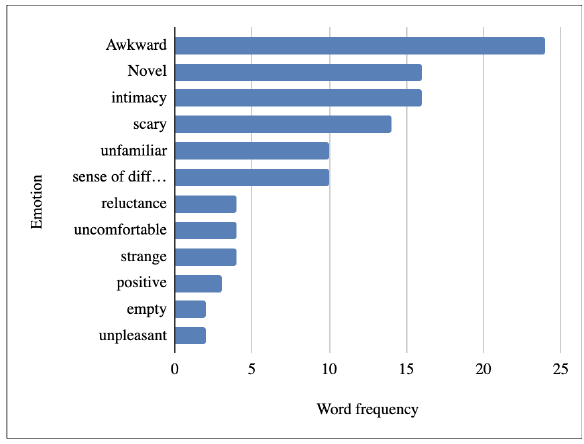
Figure 5. Word Frequency Ranking for ‘Emotion’.